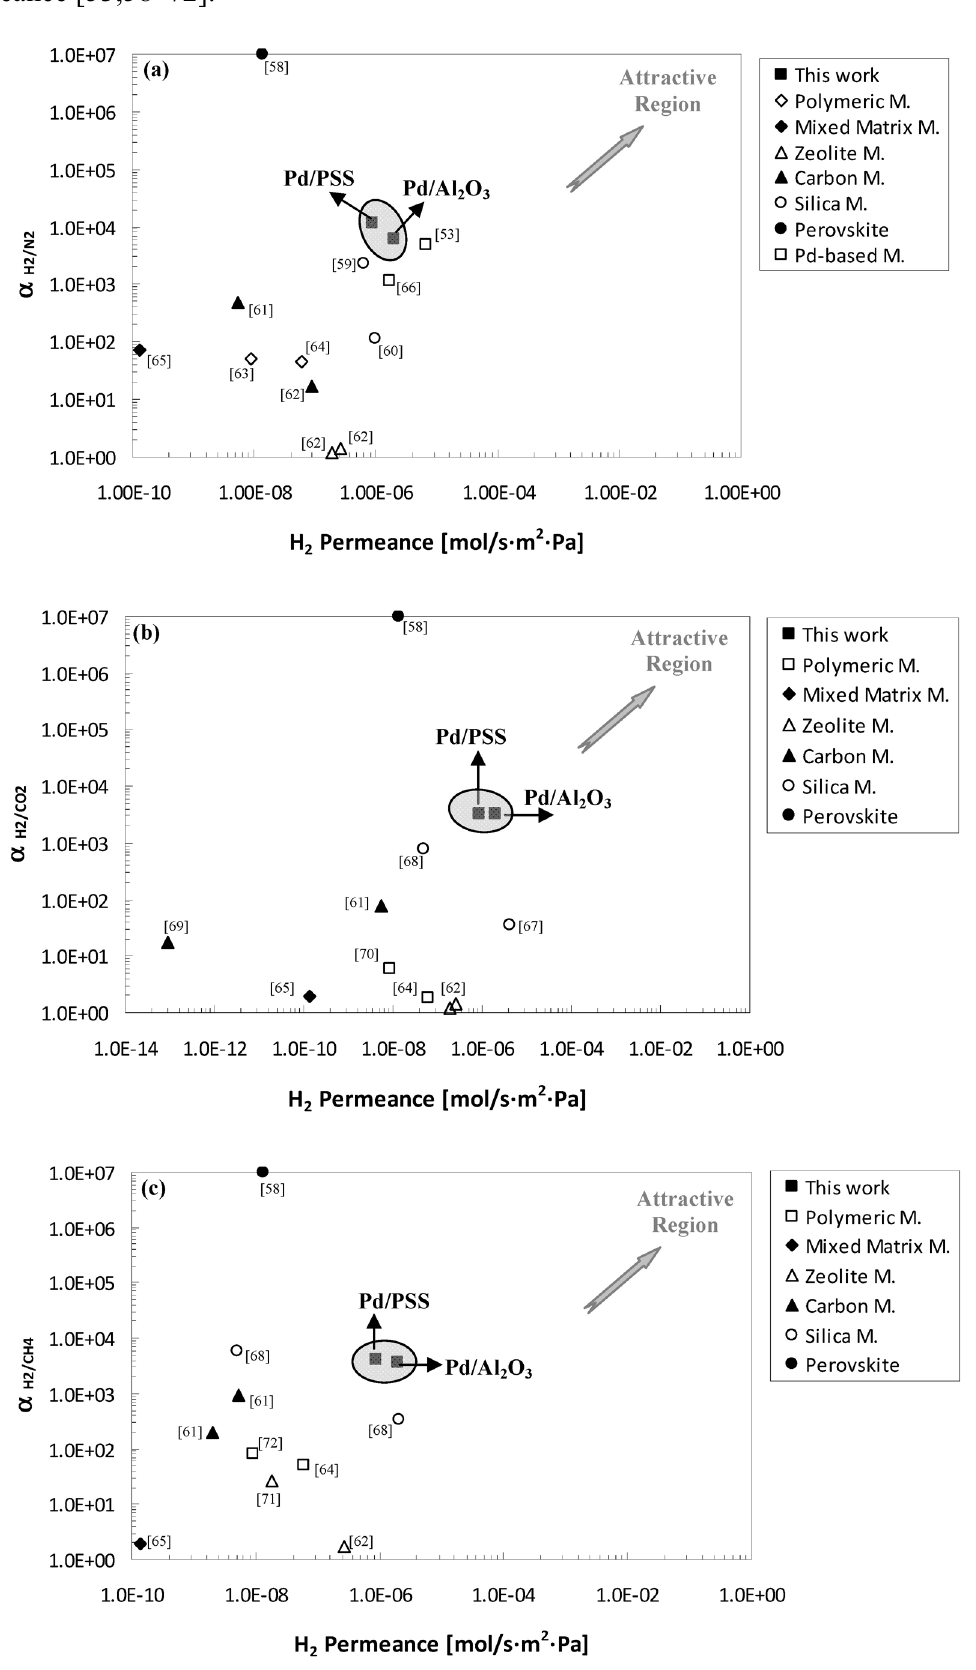
Figure 7. Comparison with scientific data. ( a ) α Permeance